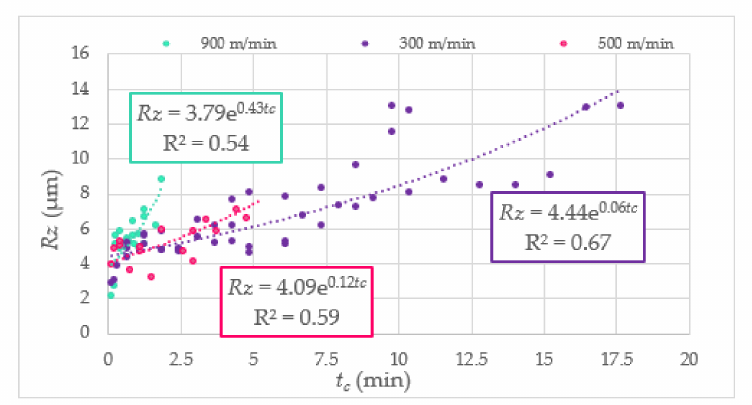
Figure 7. The Rz parameter in function of cutting time.